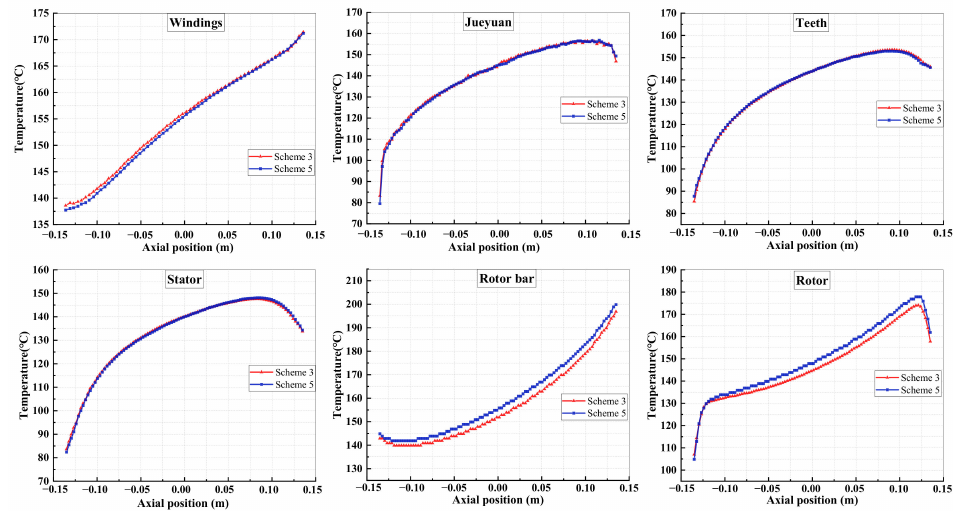
Figure 11. Temperature comparison of nonlinear variable cross-section and linear variable cross- section stator ventilation hole.